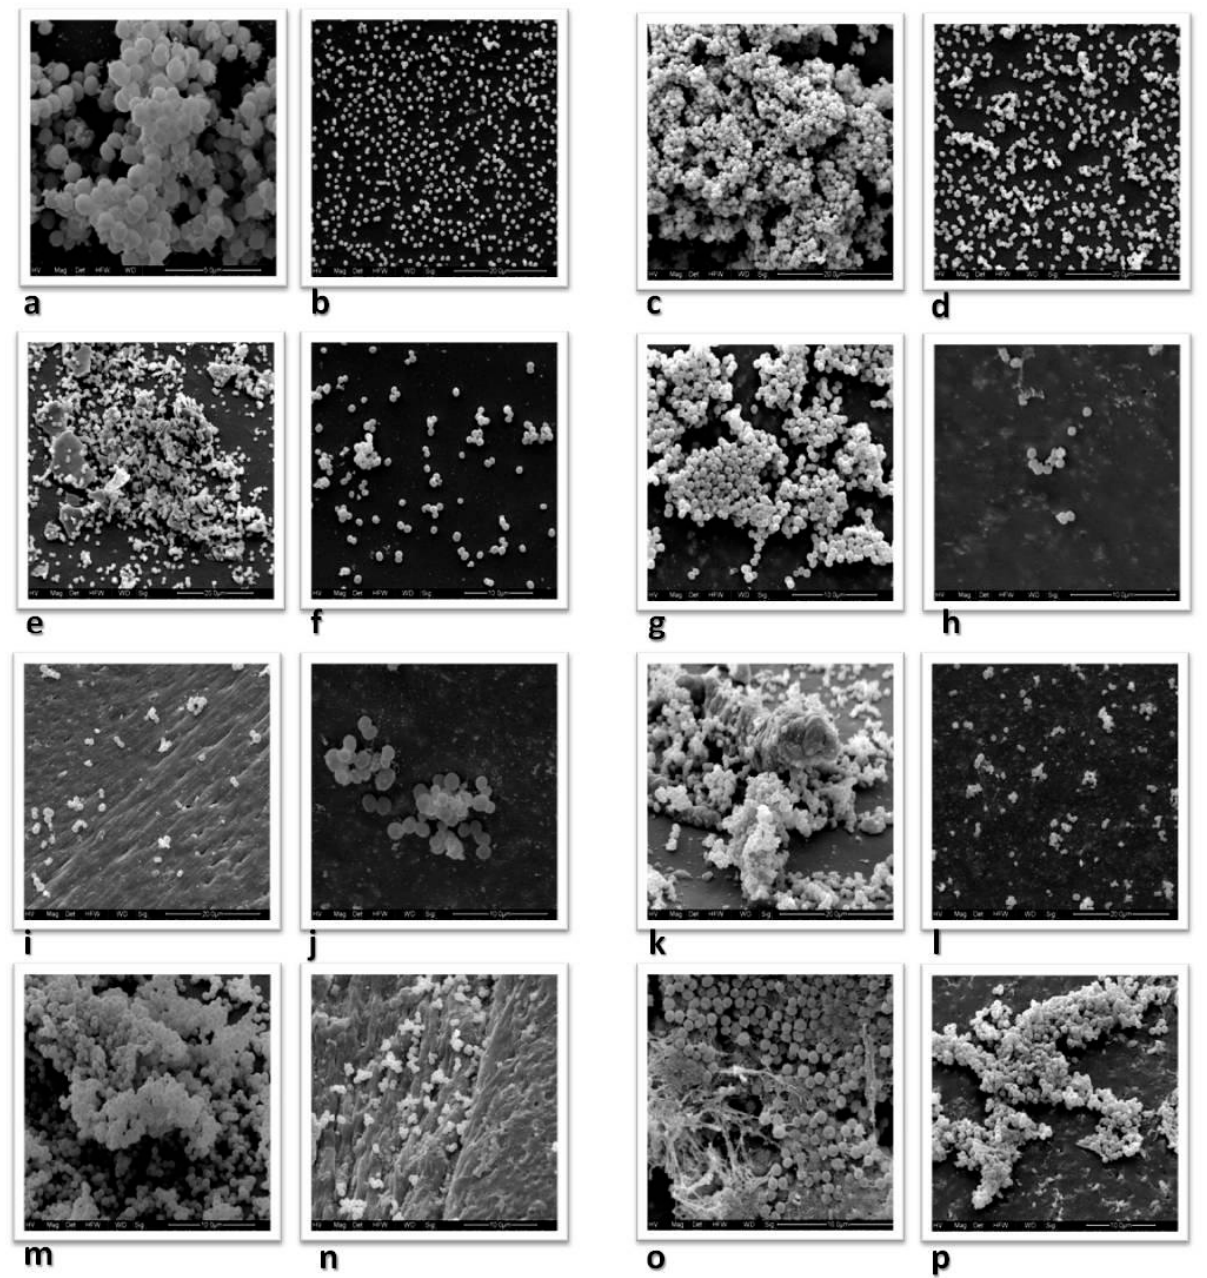
Figure 3. ( a , b ): SEM results for the same S. saprophyticus isolate: ( a ): pure culture; ( b ): S. saprophyticus isolate incubated with 200 µg/mL RIP. ( c , d ): S. epidermidis ADBC carrying the complete operon; ( c ): pure culture; ( d ): S. epidermidis incubated with 200 µg/mL RIP. ( e , f ): S. epidermidis DBC carrying the icaDBC genes; ( e ): pure culture; ( f ): S. epidermidis incubated with 200 µg/mL RIP. ( g , h ): S. haemolyticus A expressing only the icaA gene; ( g ): pure culture; ( h ): S. haemolyticus incubated with 200 µg/mL RIP. ( i , j ): SEM results for the same S. hominis isolate; ( i ): pure culture; ( j ): S. hominis incubated with 200 µg/mL RIP. ( k , l ): SEM results for the same S. warneri isolate; ( k ): pure culture; ( l ): S. warneri incubated with 200 µg/mL RIP. ( m , n ): SEM results for S. lugdunensis : ( m ): pure culture; ( n ): S. lugdunensis incubated with 200 µg/mL RIP. ( o , p ): SEM results for the same S. aureus isolate: ( o ): pure culture; ( p ): S. aureus incubated with 200 µg/mL RIP. Scale bars: ( a , b ): 10 µm; ( c , d , k , l , m , n , o , p ): 20 µm; ( e , f , g , h ): 10 µm; ( i , j ): 5 µm.